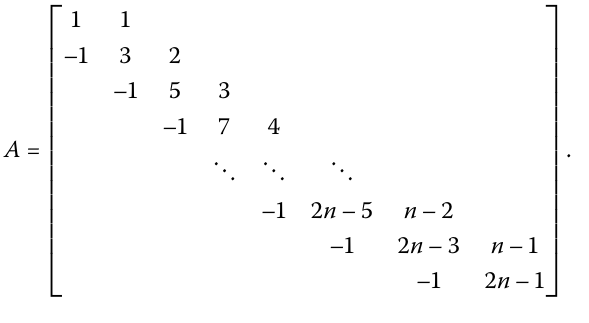
Table 1 The comparison results on the spectral radius of the SOR iterative matrix of A for different ω ω